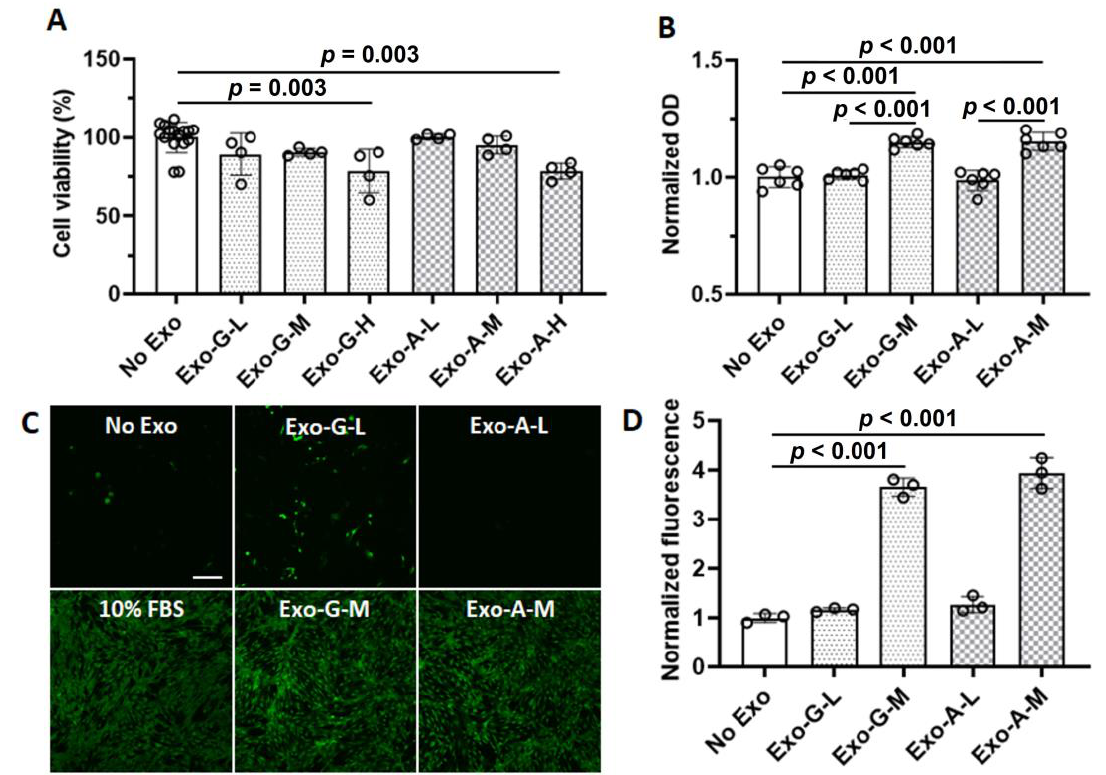
Figure 2. The effect of dental pulp stem cells-derived exosomes (DPSC-Exos) on cell toxicity, prolif- eration, and migration. Exosomes were isolated from DPSCs cultured under a growth (Exo-G) or angiogenic differentiation condition (Exo-A) and used at a concentration of 5 × 10 7 /mL (Exo-G-L or Exo-A-L), 5 × 10 8 /mL (Exo-G-M or Exo-A-M), or 5 × 10 9 /mL (Exo-G-H or Exo-A-H). ( A ) Cytotoxicity at 24 h ( n = 4 – 16). ( b ) Cell proliferation at 4 days ( n = 6). ( c ) Representative confocal images of mi- grated cells. FBS: fetal bovine serum. Green: Calcein AM. Scale bar: 200 µm. ( D ) Quantified fluores- cence for cell migration ( n = 3).